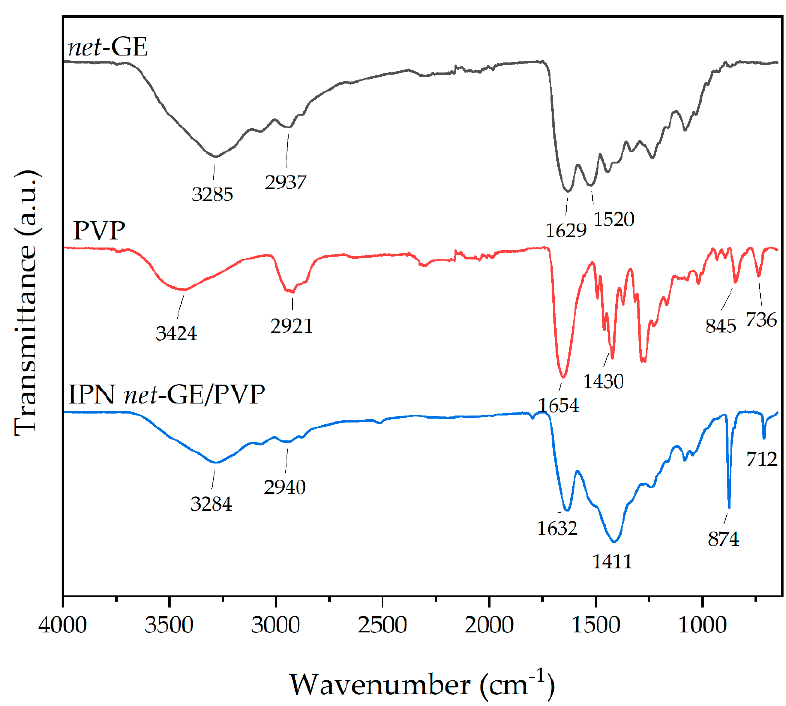
Figure 2. FTIR-ATR stacked